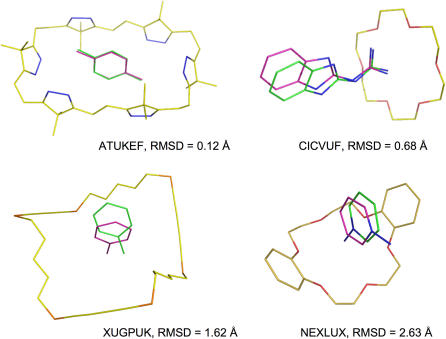
Overlays of the EUDOC-generated and crystal structures of complexes ATUKEF, CICVUF, XUGPUK, and NEXLUX.The C atoms of the EUDOC-generated and crystal structure are green and magenta, respectively. The O, N, and S atoms are red, blue and orange respectively.